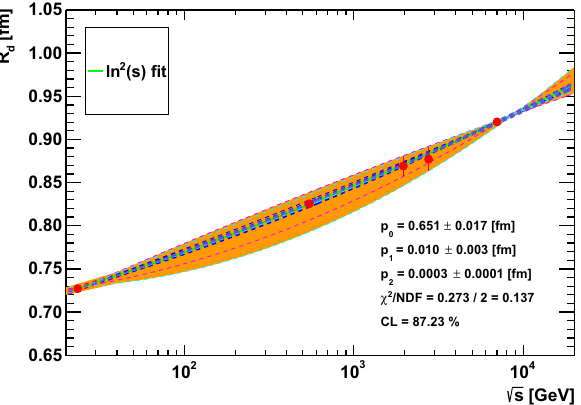
Fig. 24 Overlayingthesystematicerrorbandsonthe R q ( s ) , R d ( s ) and R qd ( s ) parameterasobtainedbythepreviousthreefiguresindicatesthat √ √ s = 7 TeV down to 200 GeV these bands overlap within one from s = 7 . 0, standard deviation. This indicates that taking into account the quadratic dependenceonln ( s ) andthecorrelationsbetweenthemodelparameters √ s = 200 GeV for allows for an estimation of the lower limit of the domain of the validity of the H ( x ) scaling, which turns out to be experimentally testable in elastic pp collisions at the RHIC